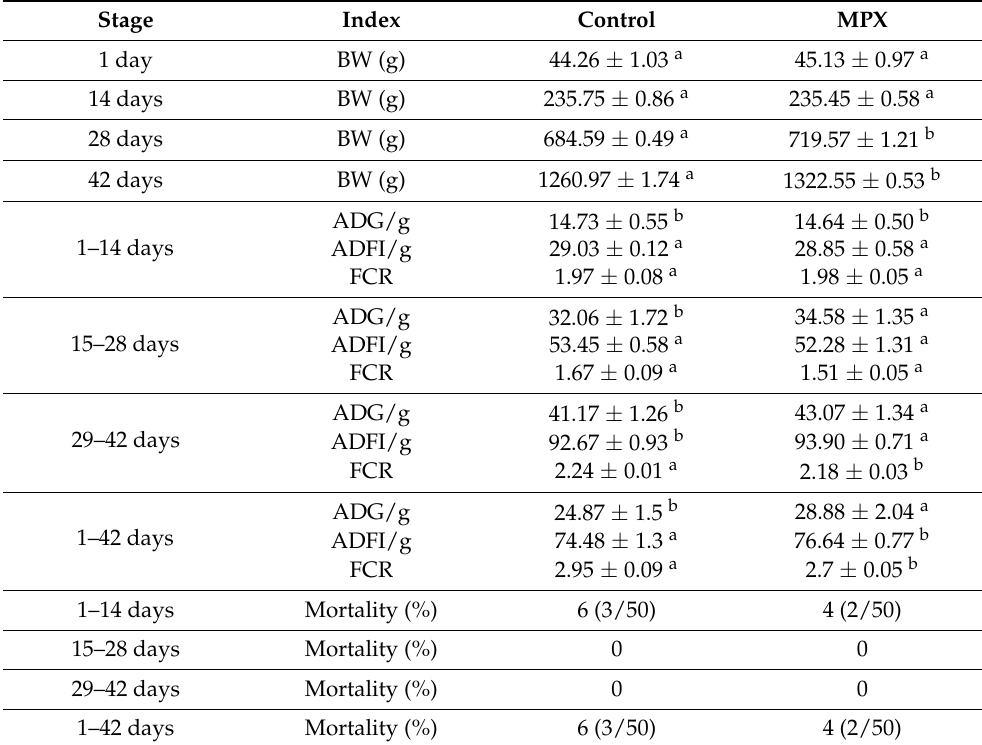
Table 3. Effects of MPX on the growth performance of broiler chickens at different